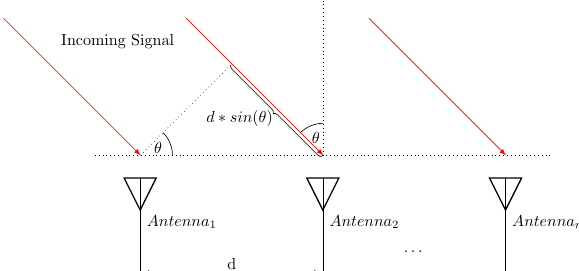
Figure 2. The angle of arrival ( θ ) can be calculated with the measurement of the incoming signal’s phase shift between the antennas.